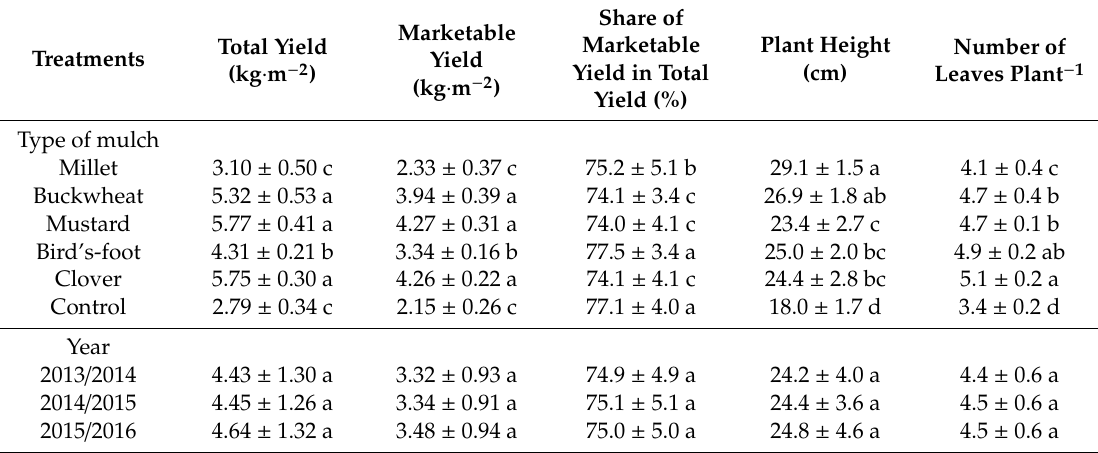
Table 3. Summary of statistical significance from analysis of